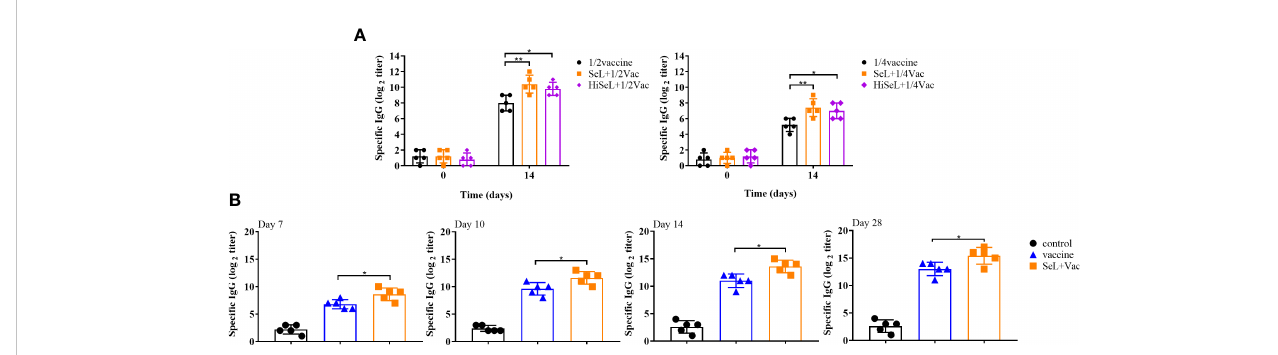
FIGURE 7 Effect of SeL or HiSeL on the humoral immune response induced by the immunization of mice and rabbits. Sera samples of mice were gathered on days 0 and14 after immunization with 1/2 and 1/4 standard vaccine doses to detect speci fi c IgG antibody response. Sera samples of rabbits were gathered on days 7, 10, 14, and 28 after immunization to detect speci fi c IgG antibody response. (A) The titer of speci fi c IgG antibody in mice sera immunized with 1/2 and 1/4 standard vaccine doses. (B) The titer of speci fi c IgG antibody in rabbit sera. Each experimental group consisted of fi ve mice or rabbits per group. Data were presented as means ± SD (*P < 0.05, and **P < 0.01). The statistical analysis was performed using one-way ANOVA or two-way